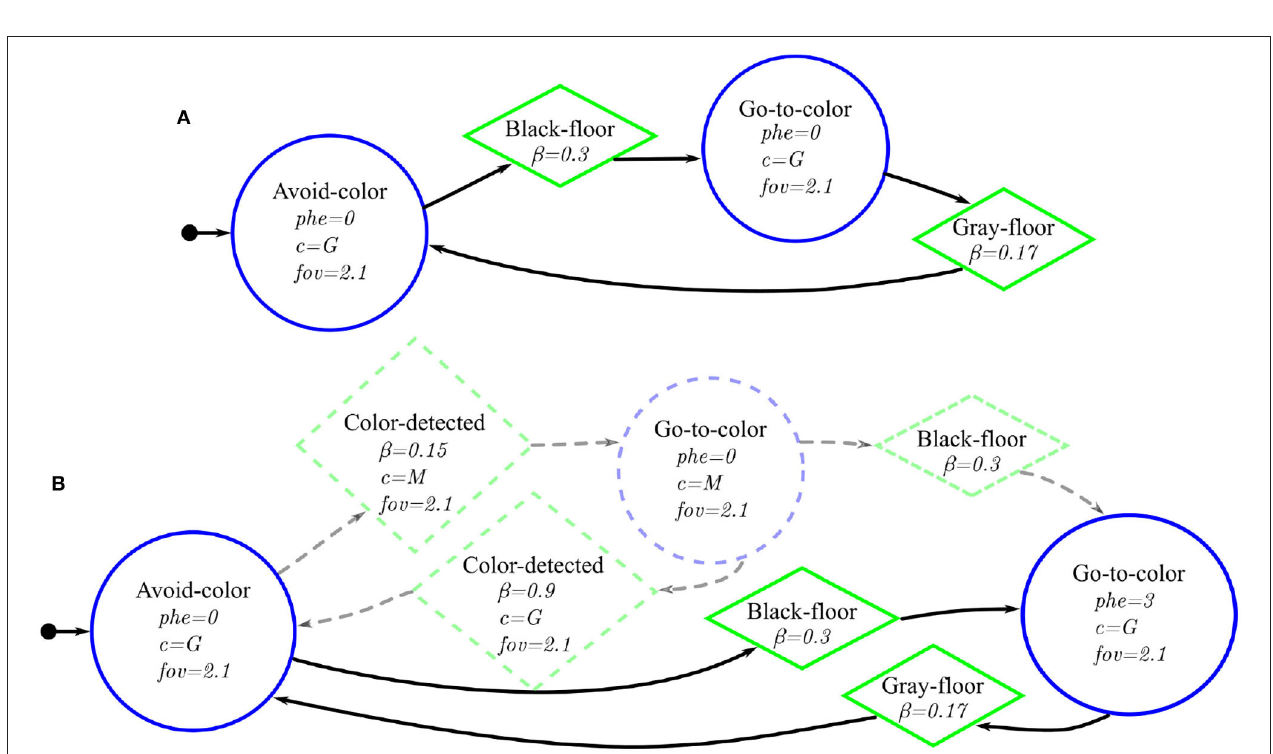
FIGURE 6 | Construction of arena for the FORAGING experiments: (A) technical representation of the arena with dimensions and positions of different zones, and (B) real arena. Measurements are expressed in meters.